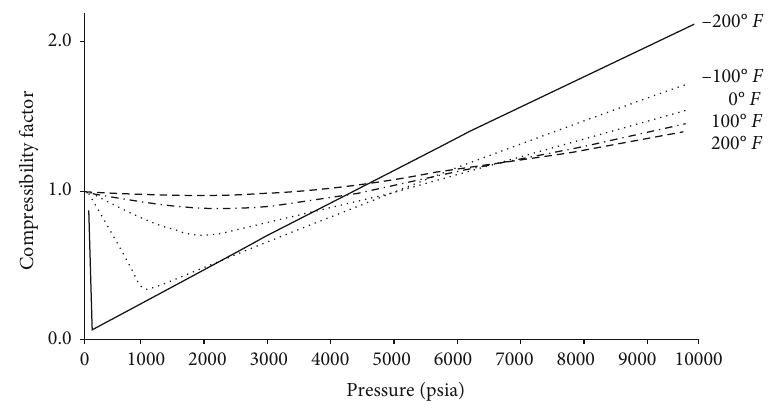
Figure 2: Change curve of gas compressibility factor [27].